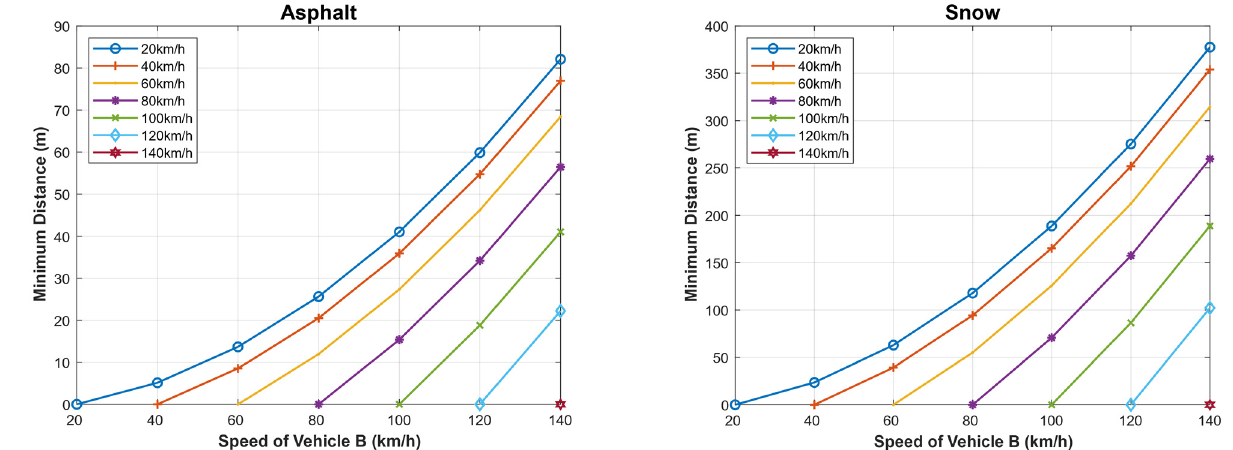
Figure 19. Minimum safe driving distance for different speeds of both the following and the followed vehicle in the case when the following vehicle is dotted with Autonomous Emergency Braking (AEB) system ( T rA = 0 s) for dry asphalt and snowy